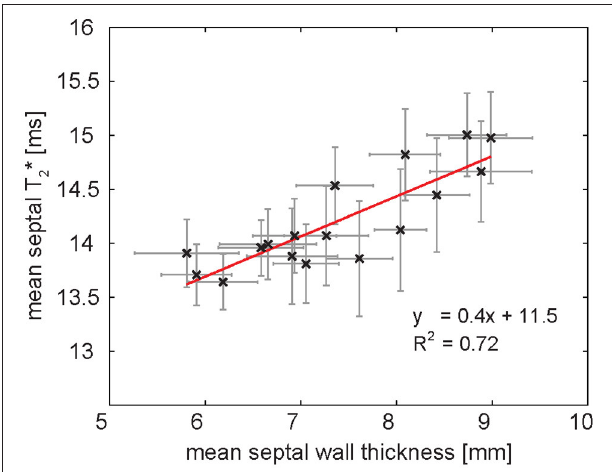
FIGURE 11 | Relationship of mean ventricular septal wall thickness and mean septal T 2 * in a group of healthy volunteers at 7.0 T. One data point corresponds to one cardiac phase. Septal wall thickness and T 2 * are linearly correlated. The result of linear regression is plotted in red. Error bars indicate